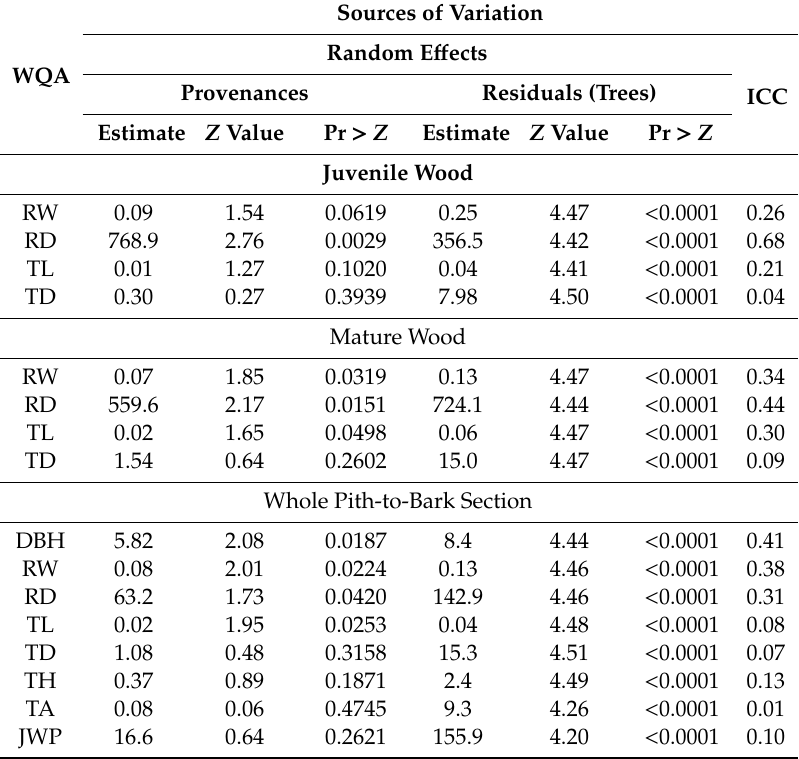
Table 3. Analysis of variance of selected wood quality attributes (WQA) for juvenile wood, mature wood and whole pith-to-bark section. Sources of Variation Random E ff ects WQA ICCProvenances Residuals